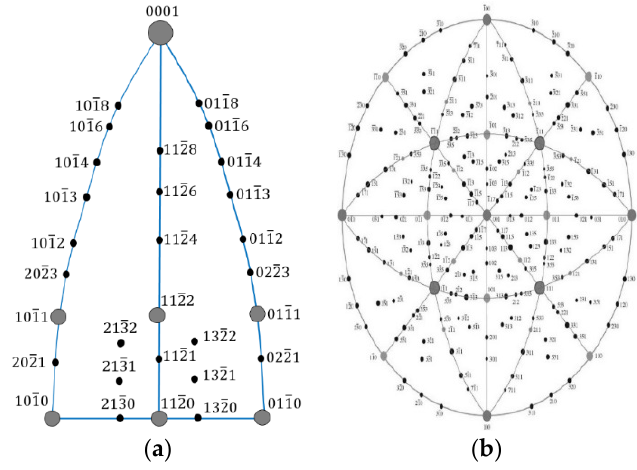
Figure 2. Stereographic projection crystallography for ( a ) hexagonal and ( b ) cubic systems.